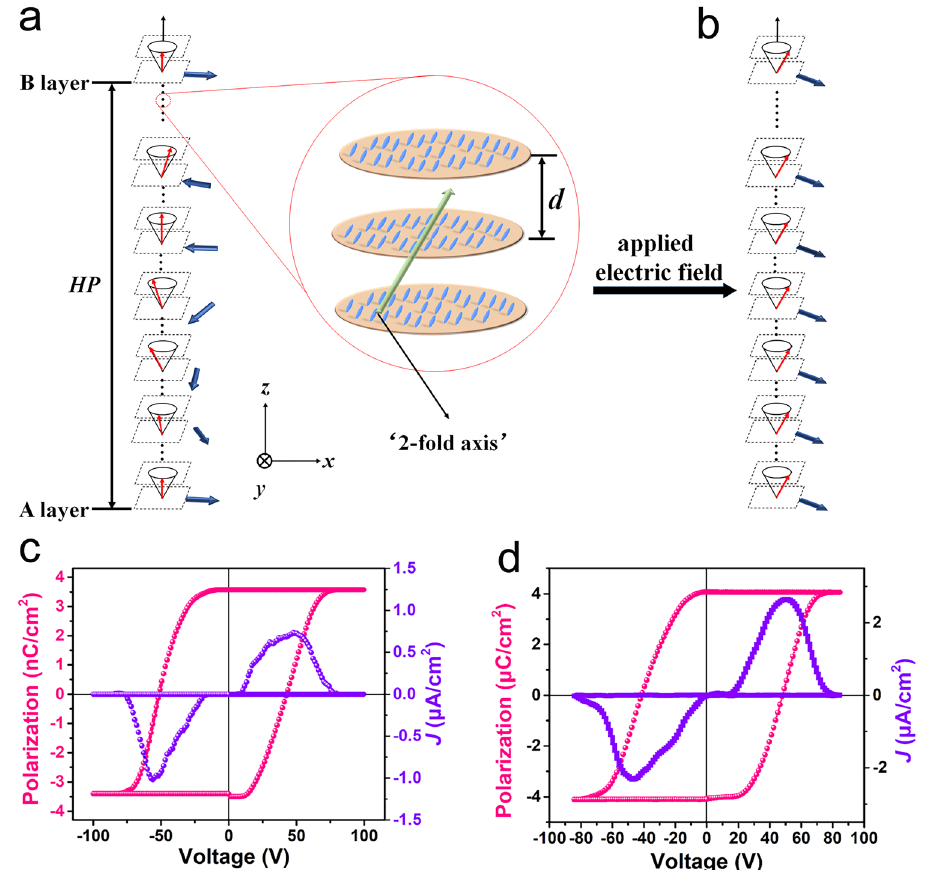
Fig. 4 | Polarization switching for 4I-CASS. a Scheme of the molecular arrange- ment in SmC* phase for 4I-CASS. The enlarged area of the red circle shows the molecular orientation between the adjacent three layers. The blue ellipses repre- sent the 4I-CASS molecules, and the distance d between the adjacent yellow disks represents the layer spacing. The red, blue, green, and black arrows represent the